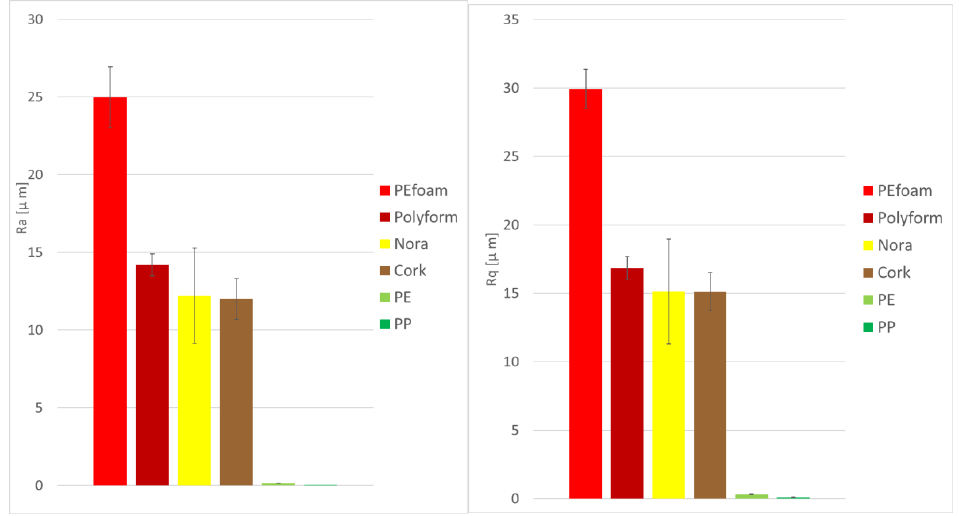
Figure 1. Roughness R a and R q of six material surfaces: PEfoam, Polyform, Nora, cork, PE and PP. Figure 2 shows FE-SEM micrographs of cellular structure of foamed samples: PE- foam, Polyform, Nora and c ork. The corresponding estimated cell sizes are 200 μm, 100 μm, 50 μm and 20 μm.